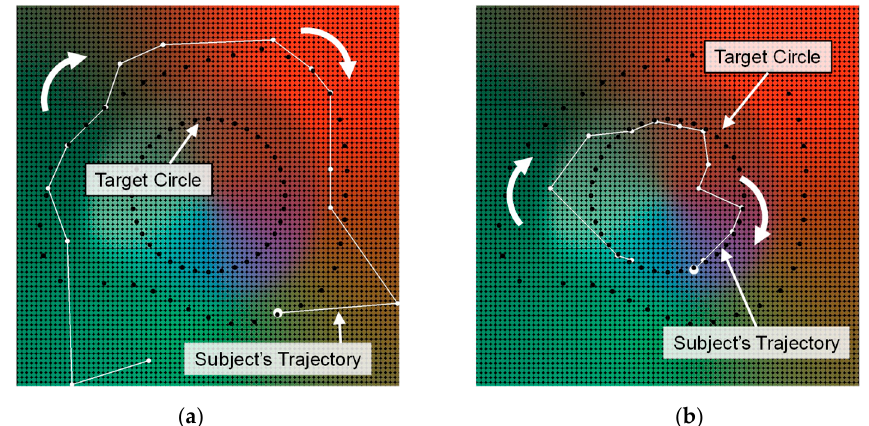
Figure 3. Projection for measuring motion data and target data as trajectories on MSM. ( a ) Motion data when the subject consciously performed Poor motion in the initial stage of the training experiment. ( b ) Motion data when the subject’s trajectory was close to the target circle in the final stage of training.